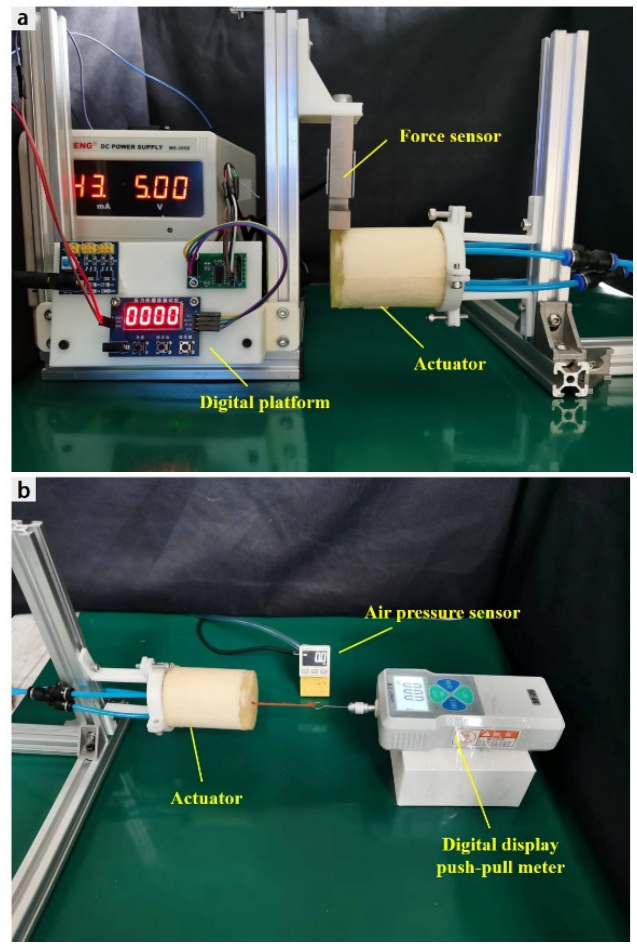
Figure 6. Actuator output force test: ( a ) bending force testing device and ( b ) contraction force testing device.